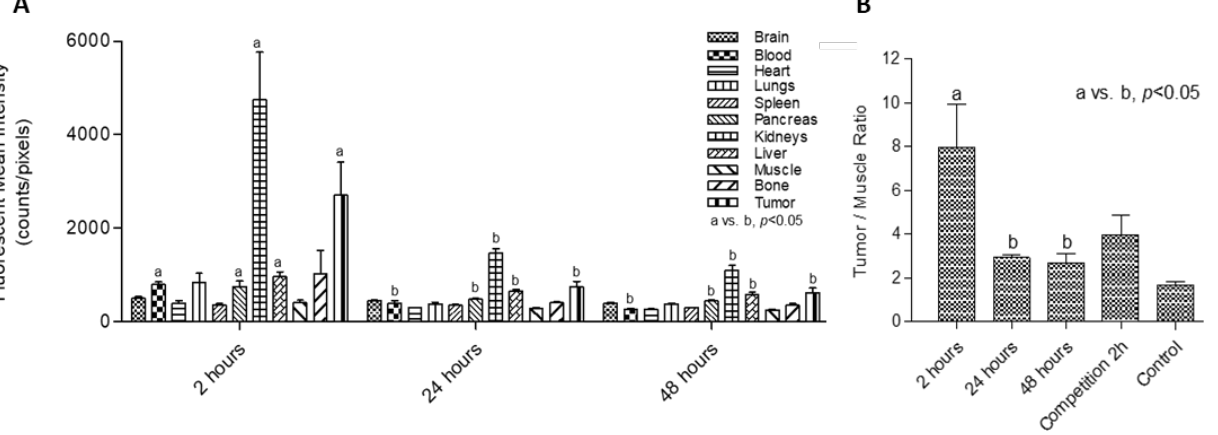
Figure 3. ( A ) Biodistribution assay: mean fluorescence intensity quantified per organ per group at each timepoint. Different letters (a,b) indicate significant differences ( p < 0.05) between fluorescence in the same organ at 2 h versus 24 and 48 h. ( B ) Tumor/muscle ratio per group. Different letters (a,b) indicate significant differences ( p < 0.05) between ratios at 2 h versus 24 and 48 h.